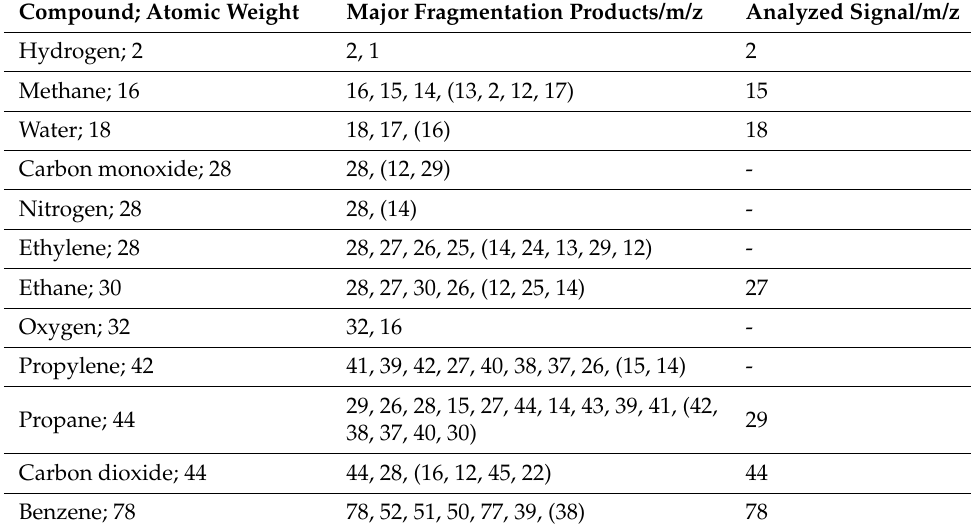
Table 1. Typical fragmentation products of given compounds within the mass spectrometer, and signal chosen for monitoring specific chemical species during this